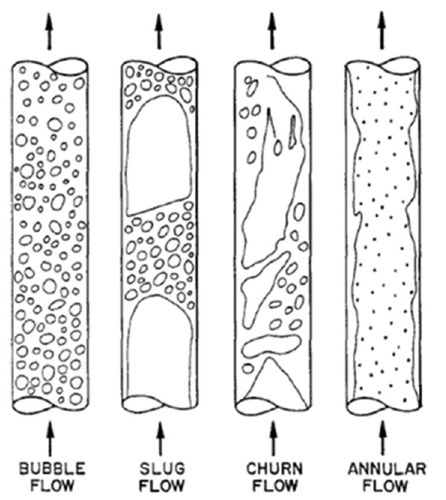
Fig. 1 Flow pattern in multiphase flow. Reproduced from Ansari et al. (1990)